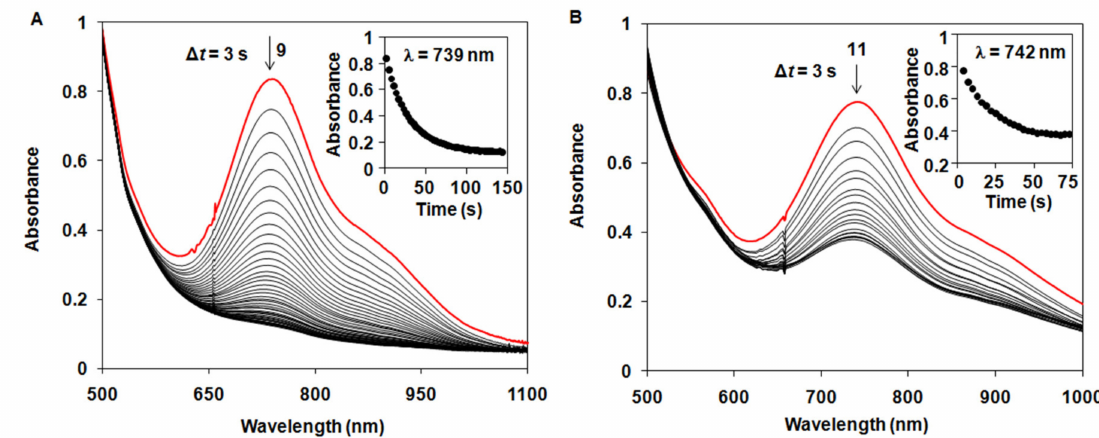
Figure 6. ( A ) UV-Vis spectral changes of 9 (2 mM, red line) upon addition of flavanone (50 mM) in CH 3 CN at 10 ◦ C. The inset shows the time course of the decay of 9 monitored at 739 nm. ( B ) UV-Vis spectral changes of 11 (2 mM, red line) upon addition of flavanone (50 mM) in CH 3 CN at 10 ◦ C. The inset shows the time course of the decay of 11 monitored at 742